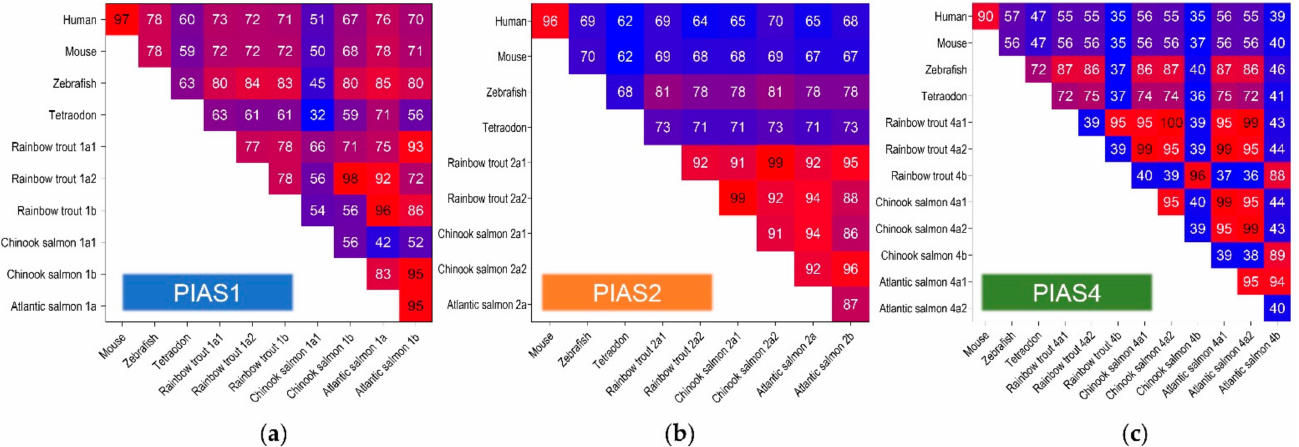
Figure 3. Sequence identity of ( a ) PIAS1 , ( b ) PIAS2 , and ( c ) PIAS4 genes from different vertebrate species, listed to the left and below the individual graphs (different PIAS gene variants are indicated behind the species name). For NCBI protein accession codes, please refer to Figure 2.